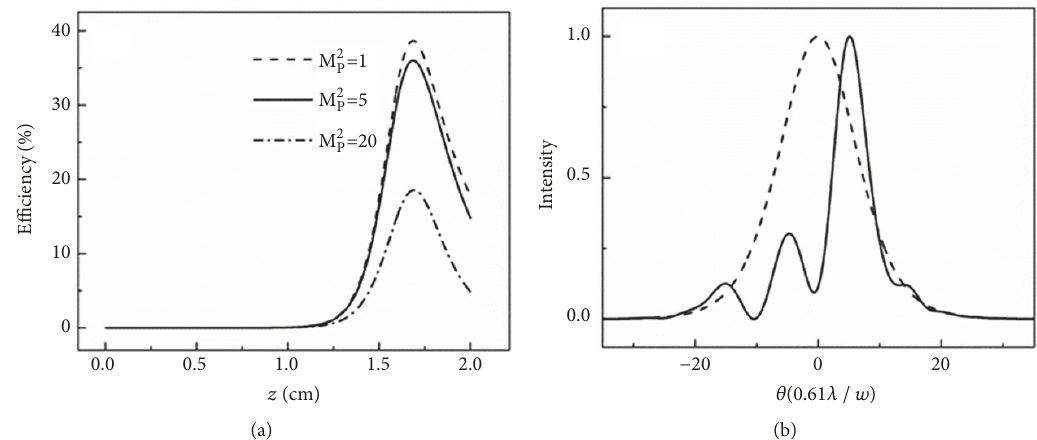
Figure 5: (a) Relationship between the signal gain and crystal length under different 𝑀 2 𝑝 factors; (b) angular spectrum of pump beam (solid line) as the signal gain reaches the peak value; the dashed line is the initial angular spectrum of input pump beam, where 𝑀 2 𝑝 = 5 , L −6 𝐿 sp = 5 L , L = 20 mm, E 0 = 10